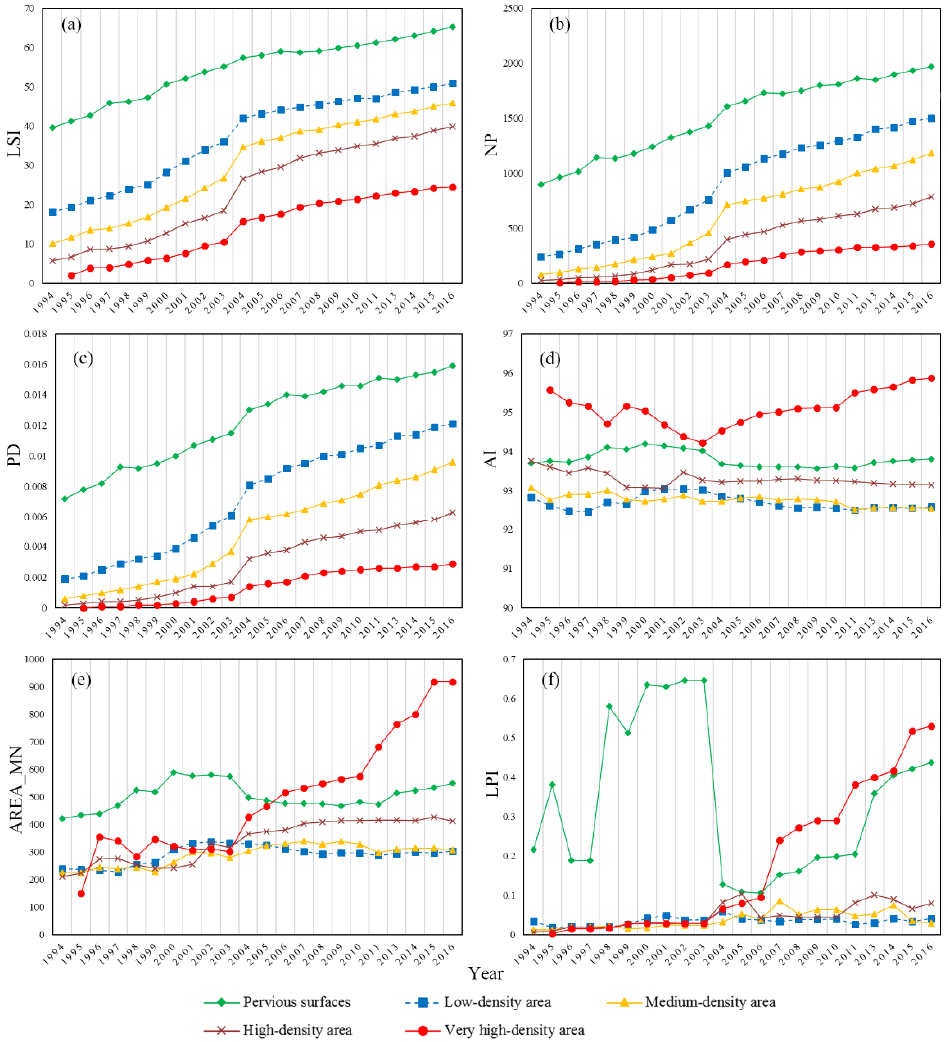
Figure 8. Landscape metrics for the five different ISA groups of the GHM Bay Area from 1994 to 2016: ( a ) Landscape shape index (LSI); ( b ) Number of patches (NP); ( c ) Patch density (PD); ( d ) Aggregation index (AI); ( e ) Mean patch size (AREA_MN); and ( f ) Largest patch index (LPI).